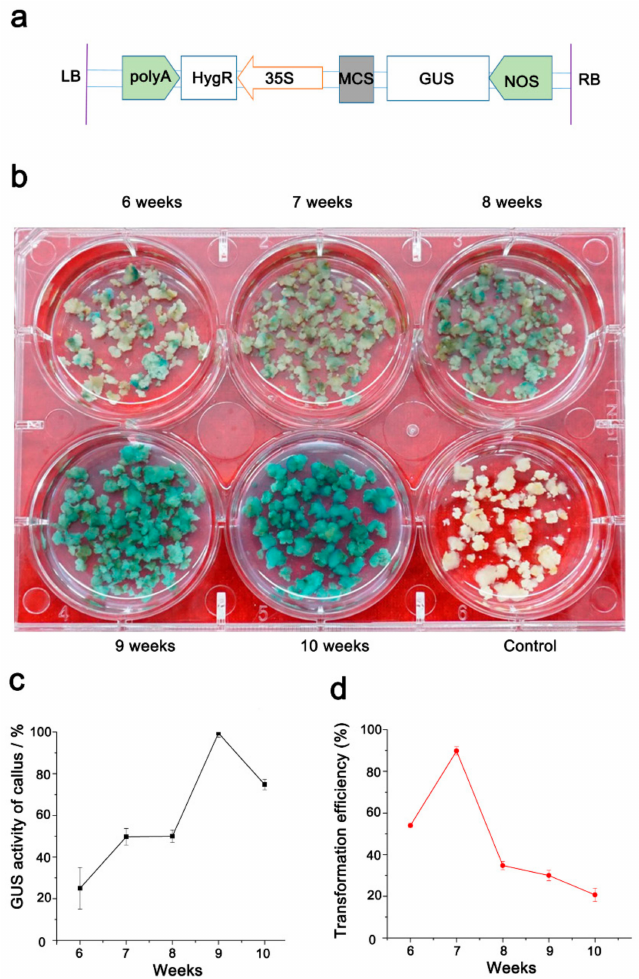
Figure 4. The β -glucuronidase (GUS) activity and transformation e ffi ciency in calli of di ff erent ages. ( a ). Schematic diagram of the T-DNA region of the binary vector pCAMBIA1391; LB: left border, RB: right border, polyA-CaMV: polyA signal, HygR: encoding hygromycin B phosphotransferase, 35S: CaMV35S enhance promoter, MCS: multiple cloning site, GUS: encoding β -glucuronidase, NOS-nopaline synthase terminator. ( b ). The GUS activity examination of calli with di ff erent ages. ( c and d ). Statistical analyses of the GUS activity in callus from di ff erent weeks ( c ) and the final transformation e ffi ciency ( d ). For each treatment, three replicates were conducted. Error bars represent ± SE, n =